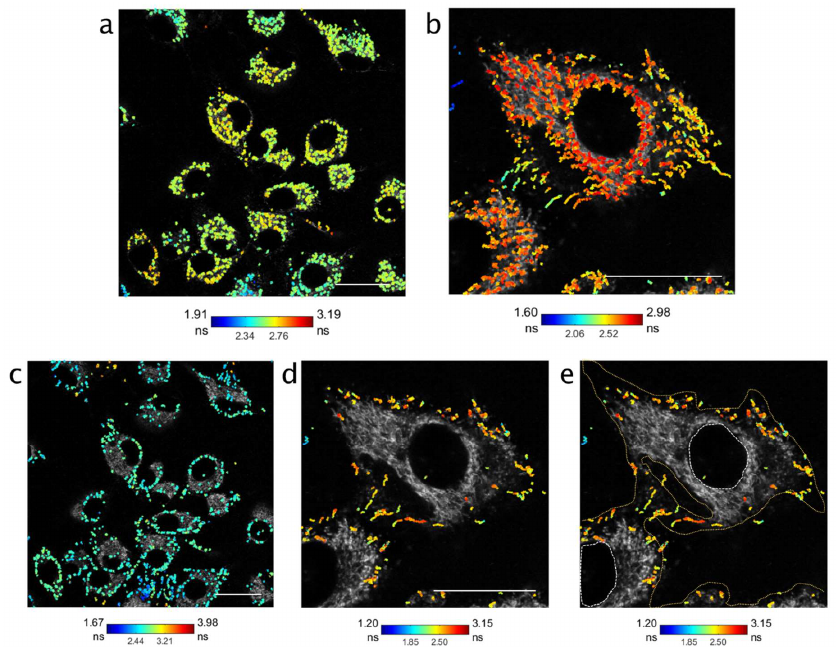
Figure 5. Localization of nanoparticle trajectories during dynamic imaging to identify changing lifetimes over single trajectories (>120 unbinned frames, with sustained photon counts >20 Mcps). Imaged at 24 h post nanoparticle addition, measured using PicoQuant RapidFLIM. ( a ) Tracks where the lifetime range over each trajectory was less than the mean ∆ lifetime ( x = 0.39 ns) at 24 h appeared to lie within cytoplasmic boundaries. Frame rate 2.62 s, with cumulative trajectories across >150 frames. ( b ) Trajectories in a single cell identifying longer lifetimes within the cytoplasmic compartment. Cumulative trajectories across 120 frames, with frame rate of 0.66 s. ( c ) In contrast, tracks above the mean ∆ lifetime shown to localize near cell boundaries, both internally and externally. ( d ) Nanoparticle tracks in a single cell, above the mean ∆ lifetime with ( e ) demarcation of ( d ) with extracellular and nuclear boundaries (yellow and white dotted lines, respectively). Scale bar in all panels, 25 µ